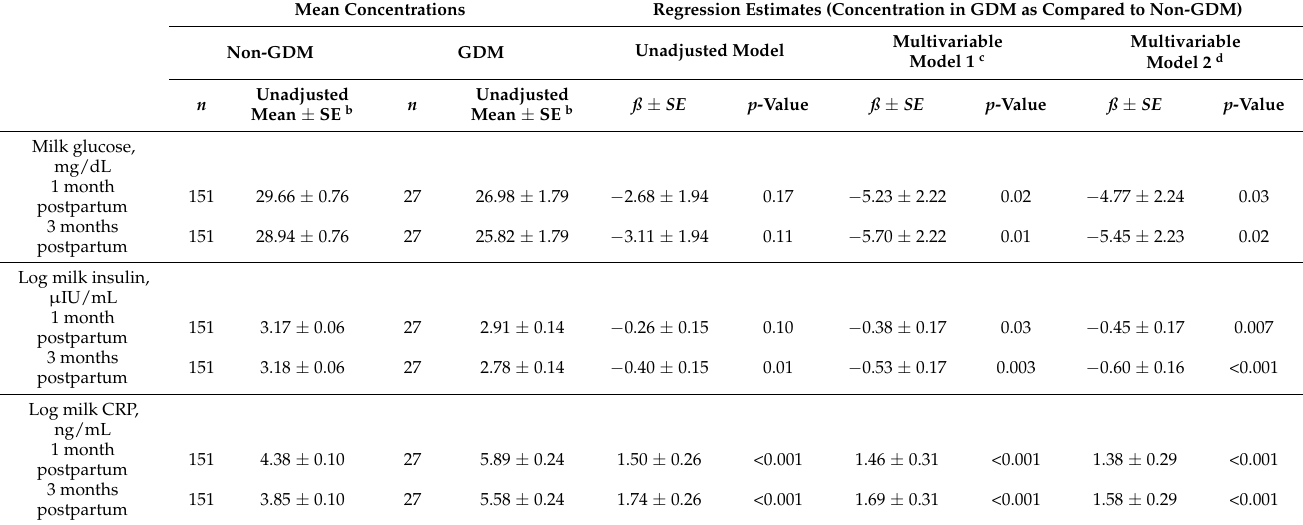
Table 2. GDM-related differences in human milk hormone and cytokine concentrations at 1 and 3 months postpartum in 178 women with complete milk composition data a . Mean Concentrations Regression Estimates (Concentration in GDM as Compared to Non-GDM) Non-GDM GDM Unadjusted